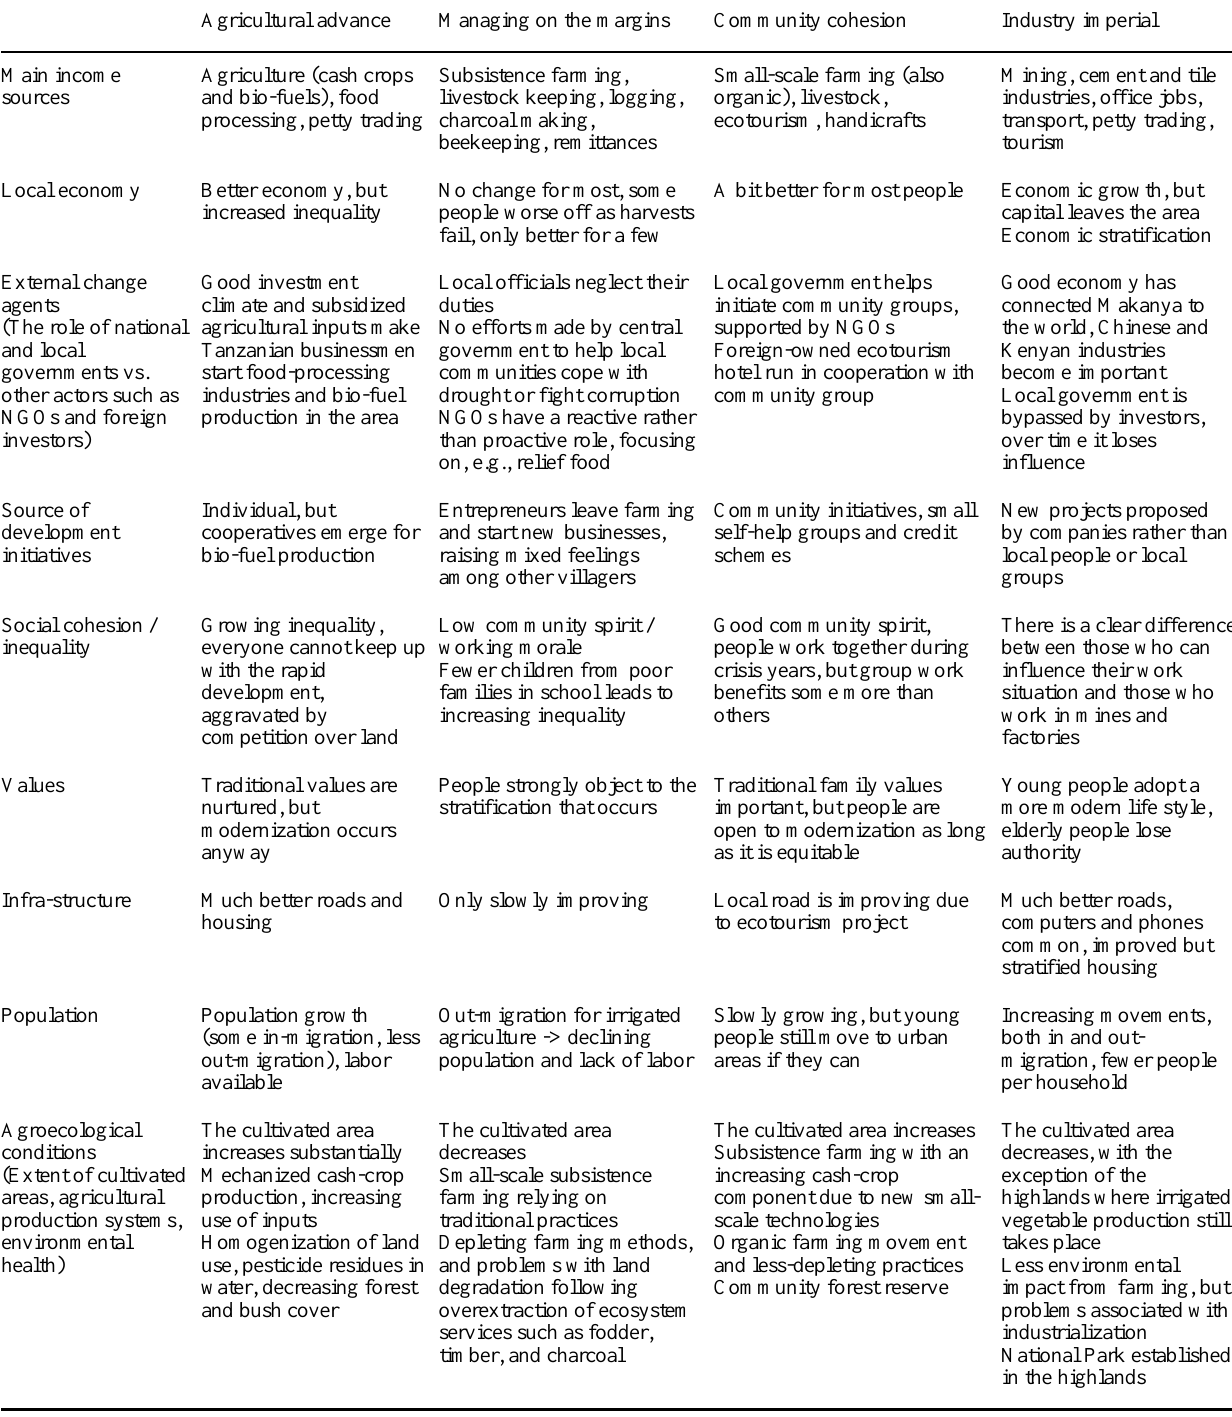
Table 4. Scenario contrasts. The first column lists nine themes that were common for all scenarios. The table shows the main differences between the scenarios according to these